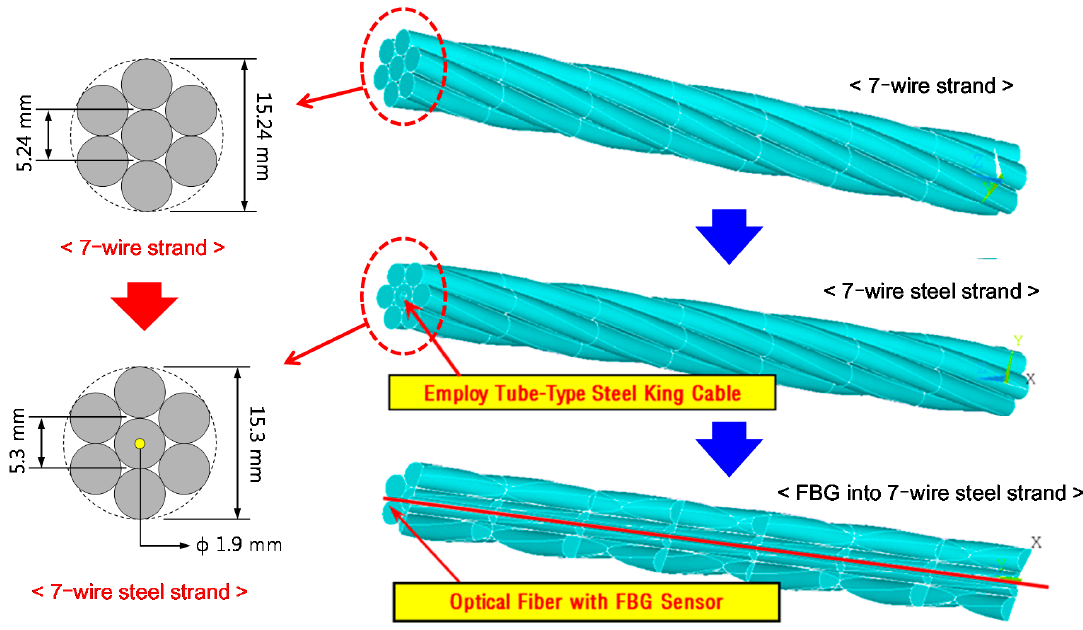
Figure 3. Concept of a seven-wire steel strand embedding an FBG sensor.